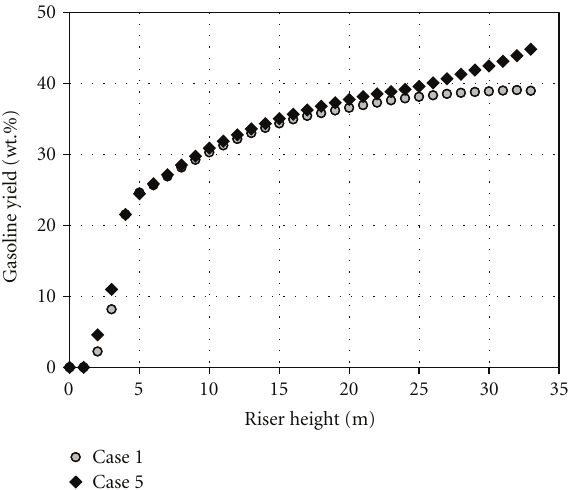
Figure 12: Average gasoline yield in cross-section planes along the height.